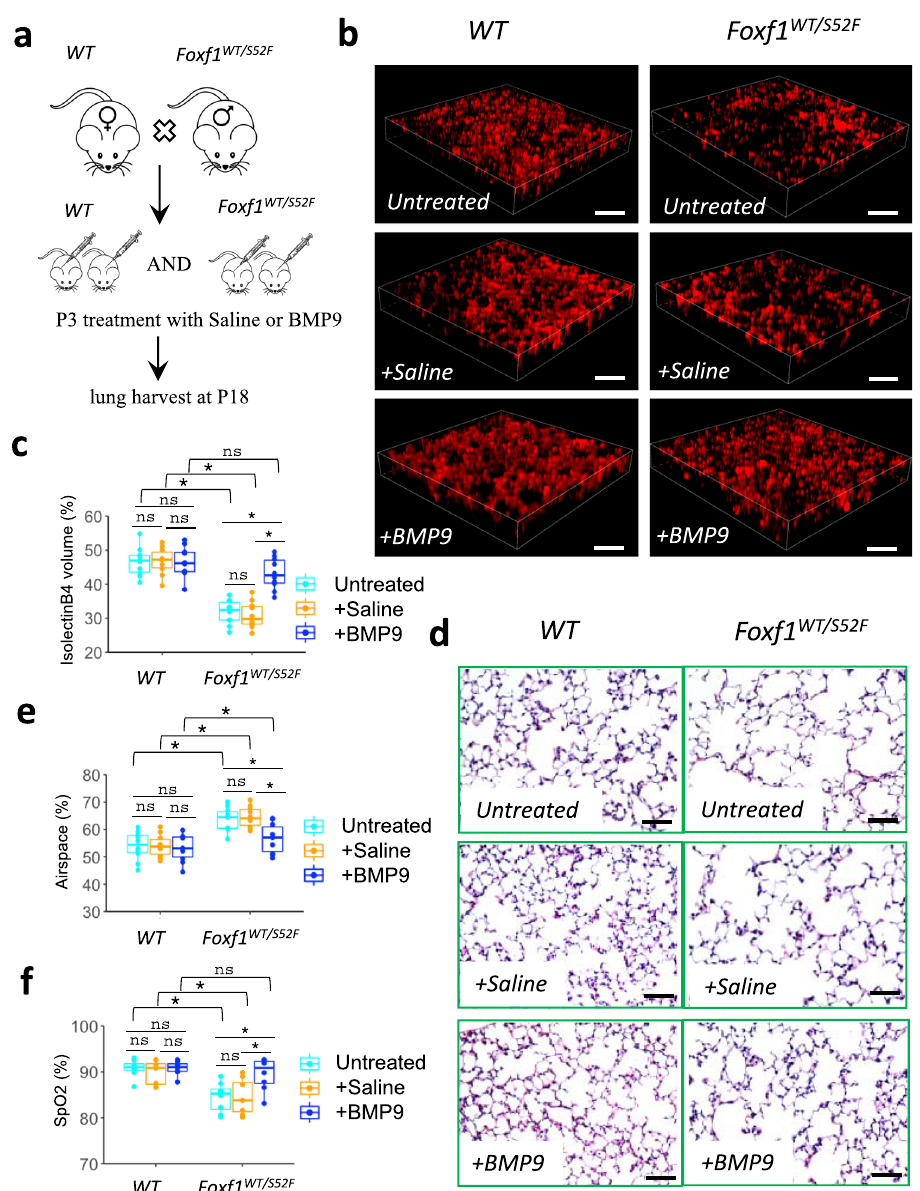
Fig. 9 BMP9 treatment increases alveolar capillary density and improves arterial oxygenation in Foxf1 WT/S52F mice. a Schematic shows BMP9 treatment in WT and Foxf1 WT/S52F littermates. BMP9 was delivered i.v. at P3. Mice treated with saline were used as controls. Lungs were examined at P18. b , c Delivery of BMP9 improves the capillary density in Foxf1 WT/S52F lungs but have no effect in WT controls. Capillary density was measured using the in vivo labeling with isolectin B4 (red) which binds to the luminal surface of perfused blood vessels. Scale bars are 50 μ m. Capillary density was quanti fi ed using high – resolution confocal microscopy. Ten random images were quanti fi ed using n = 10 mice in each group. d – e H&E staining shows that BMP9 treatment protects Foxf1 WT/S52F mice from alveolar simpli fi cation. Scale bars are 50 μ m. Ten random images were quanti fi ed using n = 10 mice in each group. f BMP9 treatment increases arterial oxygen saturation (SpO 2 ) in Foxf1 WT/S52F mice compared to WT littermates. Arterial oxygenation was measured at P18 ( n = 8 mice per group). Boxplots in c , e , and f : center line, median; box boundary, fi rst and third quartiles; whiskers denote 5th – 95th percentile. Data were shown as mean ± SD, and one – way ANOVA (two – tailed) followed by Tukey ’ s multiple comparison test was performed. * p < 0.05,** p < 0.01 ns is not signi fi